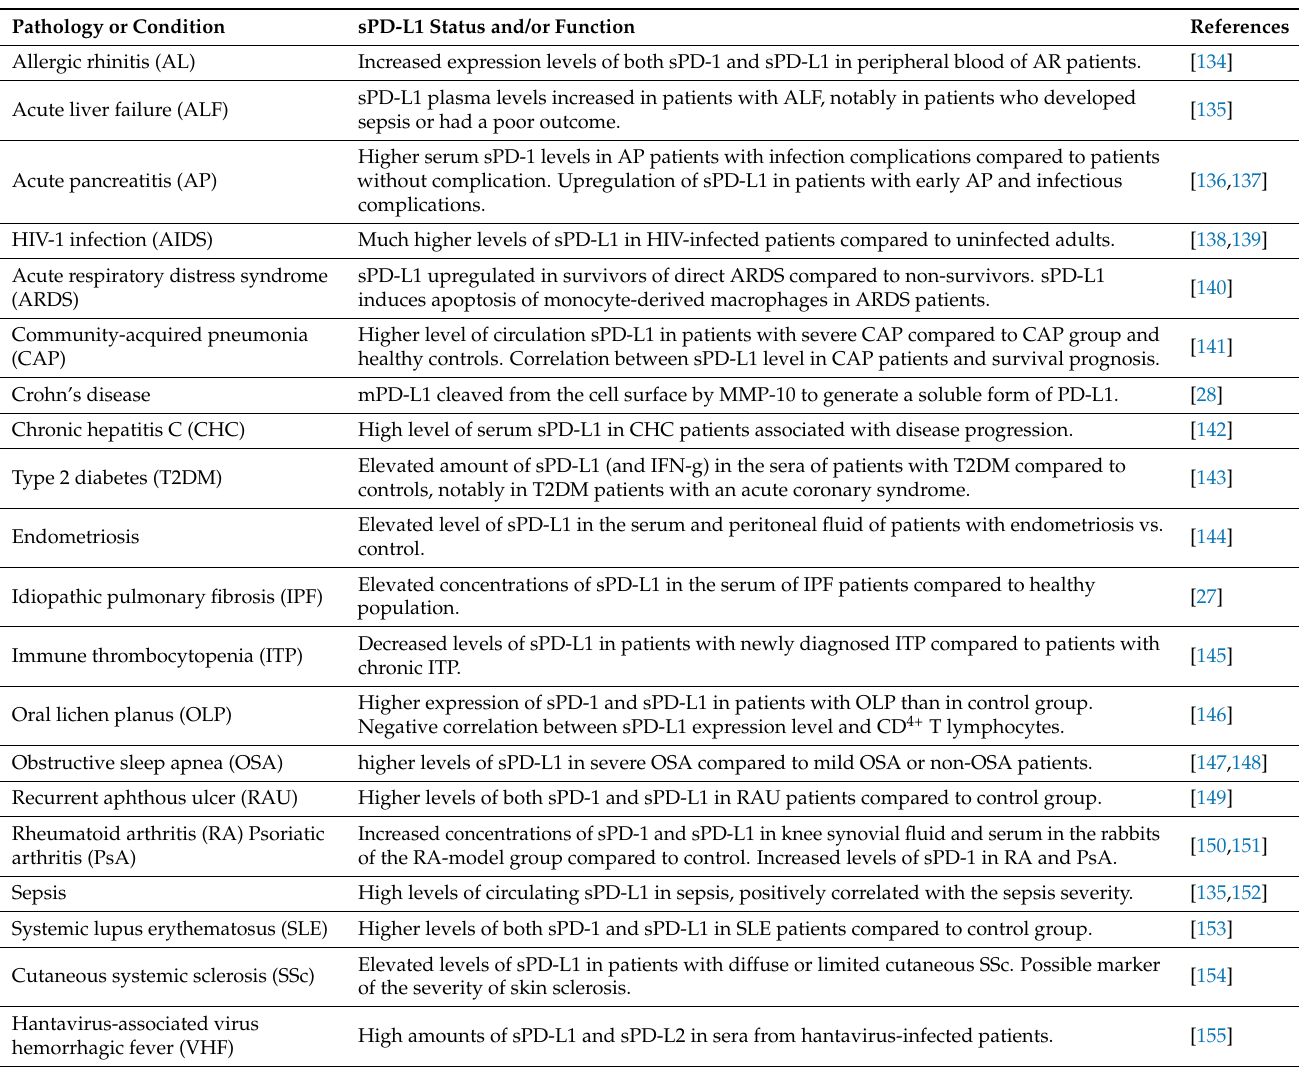
Table 1. Expression status of sPD-L1 detected in non-oncology